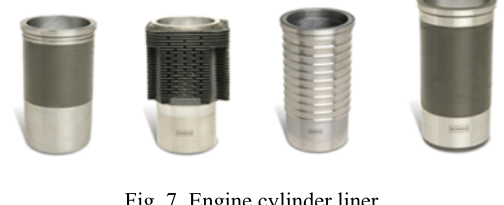
Fig. 7. Engine cylinder liner.